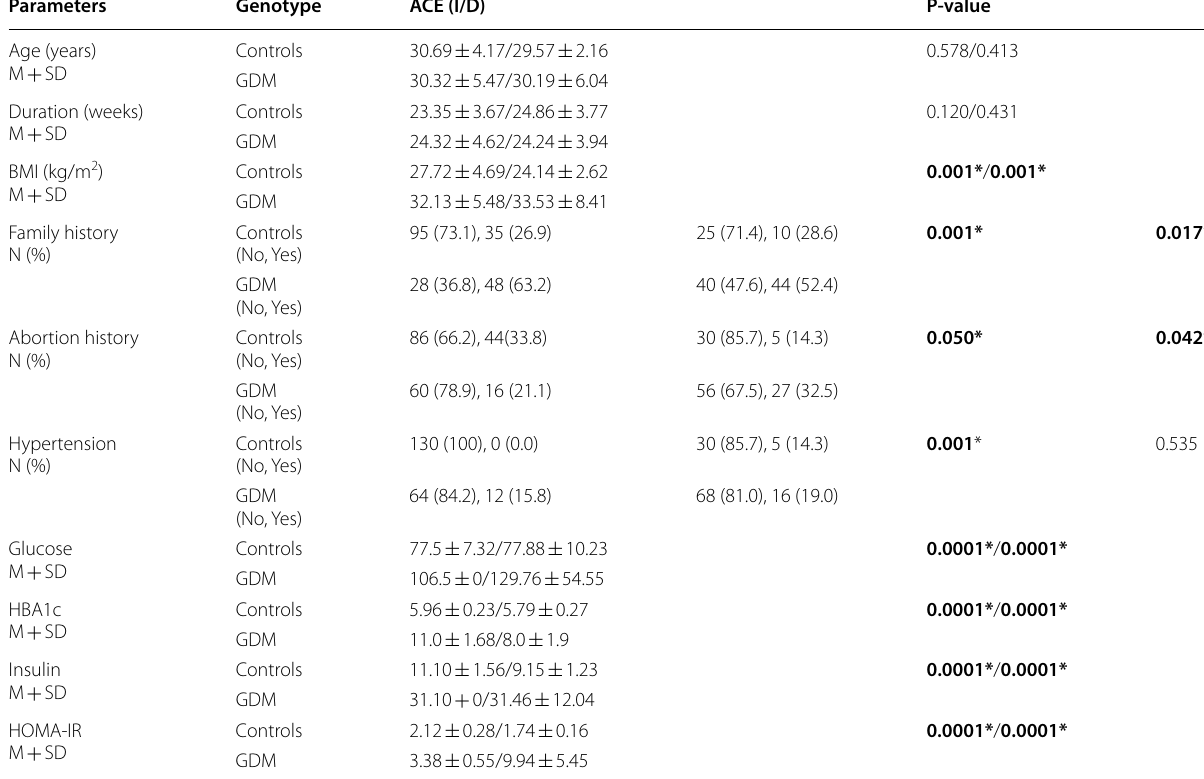
Data are presented as means